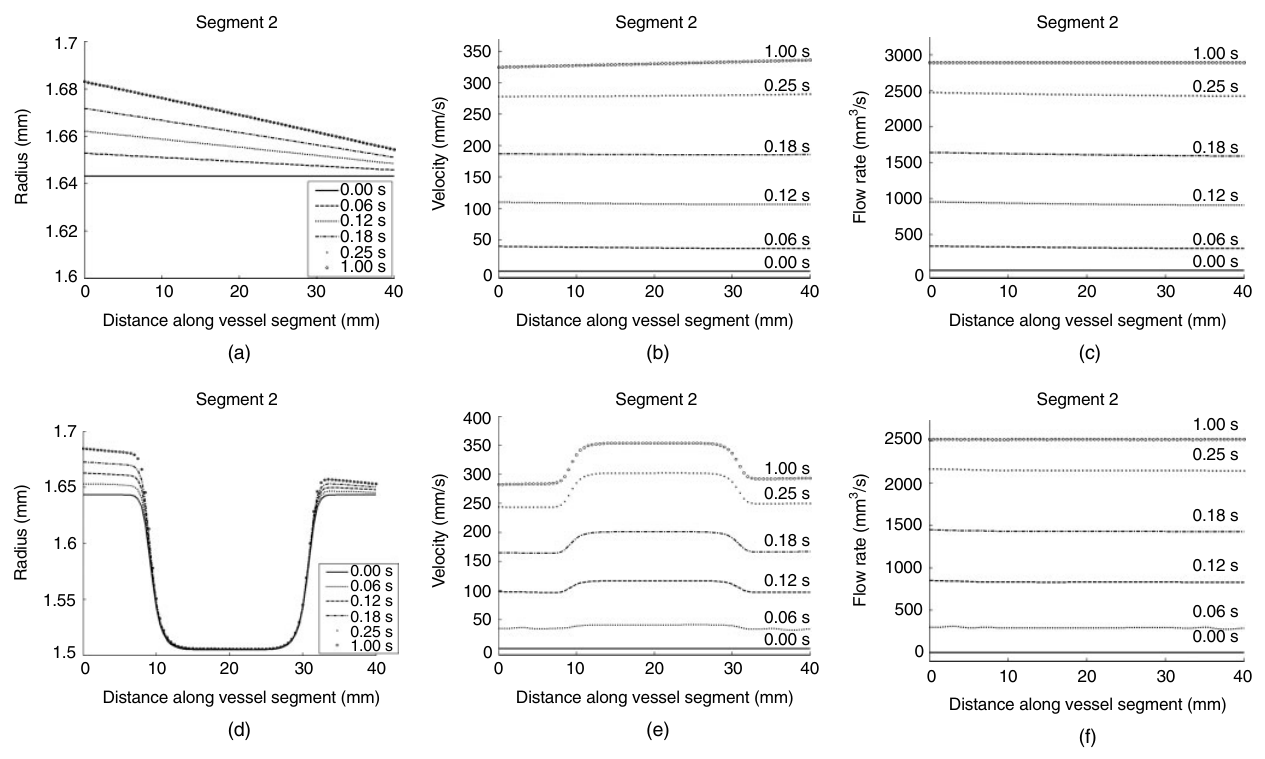
Figure 5 Radius, flow velocity and flow rate along vessel segment 2 at the times shown in the legends of the plots in the unstented ((a)–(c)) and stented ((d)–(f)) cases. The radius results for 0.25 s and 1.0 s are very similar to each other and appear together as the top line in plots (a) and (d). See Figure 1 for the positions of the vessel segment 2 in the network.